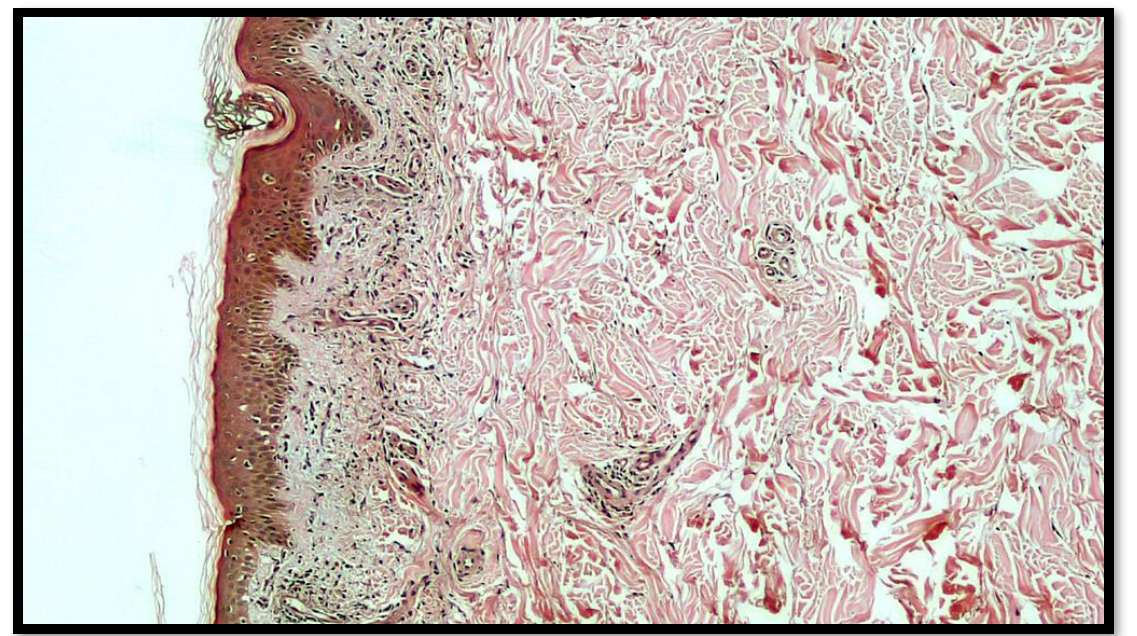
Figure 3. Histological preparation showing a moderate inflammatory infiltration, mainly constituted by lymphocytes and monocytes, with a perivascular distribution, and with rare and focal involvement of the epidermis that presented mild spongiosis (Hematoxylin-Eosin; Original Magnification 4 × ).